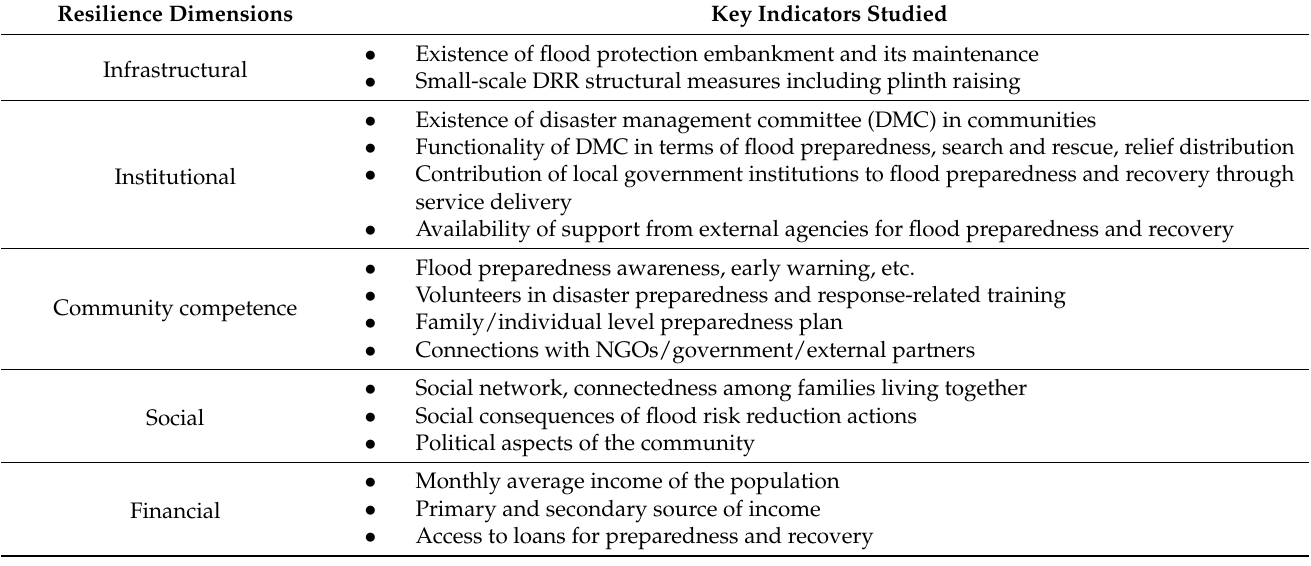
Table 1. Indicators associated with different resilience dimensions (adopted from [26]). Key Indicators